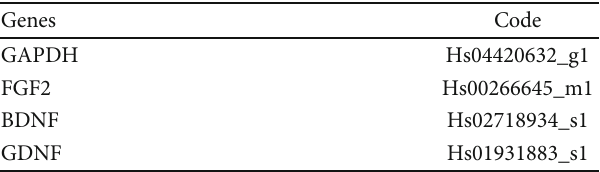
Table 1: TaqMan assays used in the qRT-PCR analysis. Genes Code